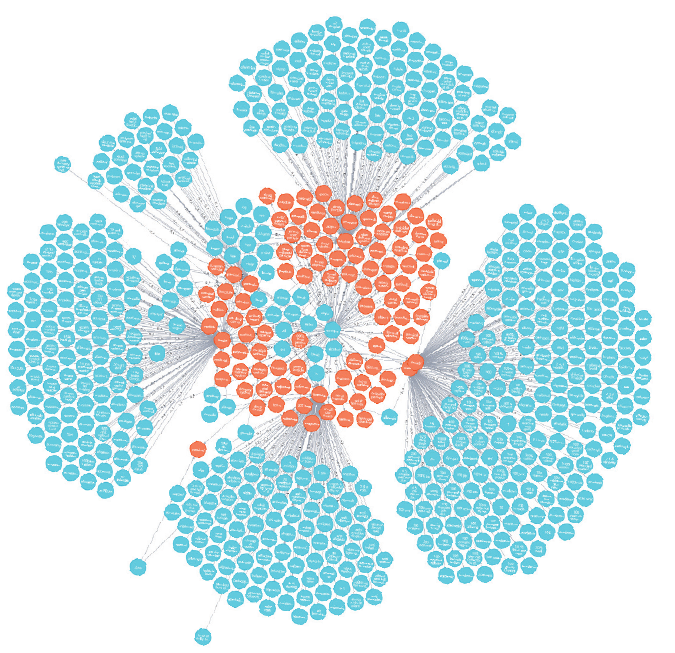
Figure 4. Partial display of the Probase KG (concepts in orange and instances in blue) connected by the “IS_A”